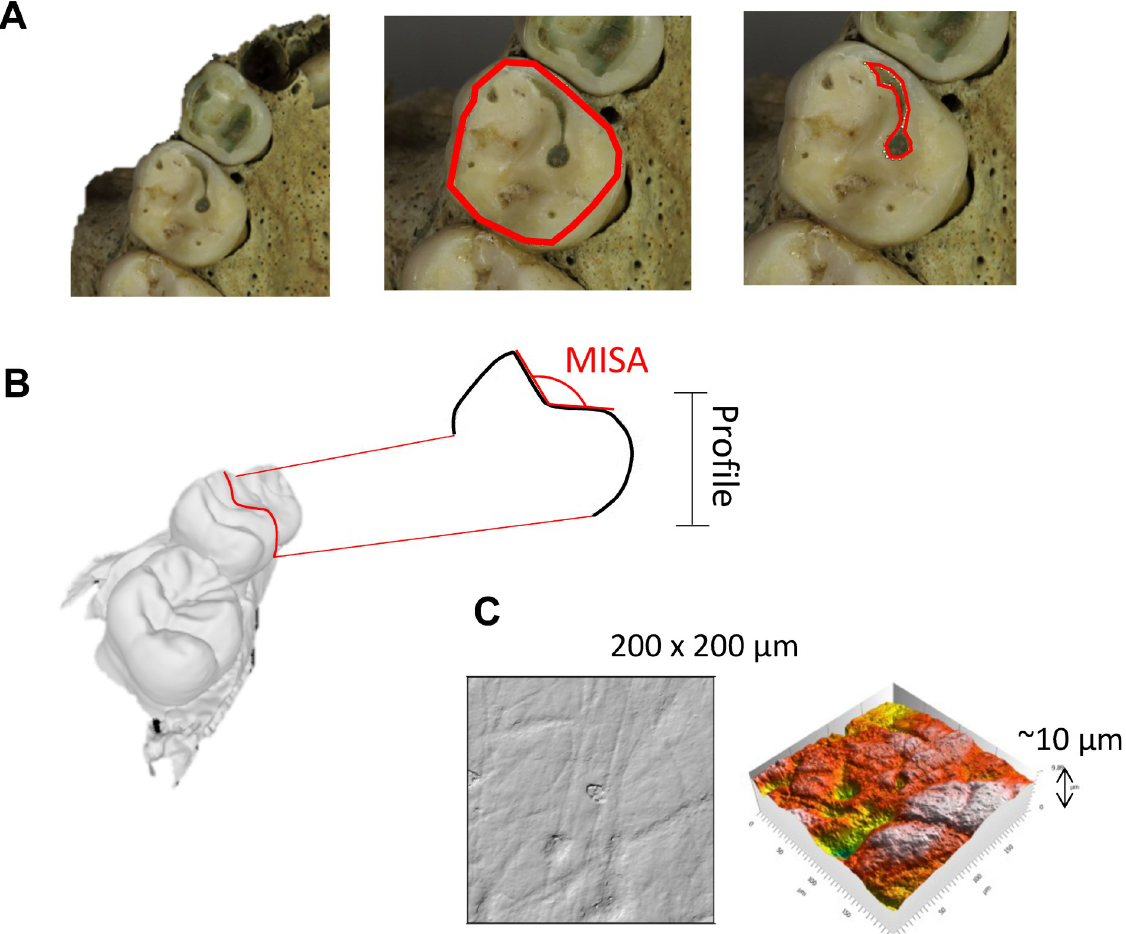
Fig 2. Dental wear measurement methods used. (A) Quantification of dentine exposure, left overview of dentition in occlusal view, centre occlusal area selection for measurement, right area selection and measurement of a dentine patch. (B) Mesial interior slope angle (MISA) measurement on a 2D profile extracted from a 3D model of the occlusal surface. (C) Dental microwear texture analysis using a confocal microscope, reconstructions of a 200 × 200 μ m area of the enamel surface in 2D and